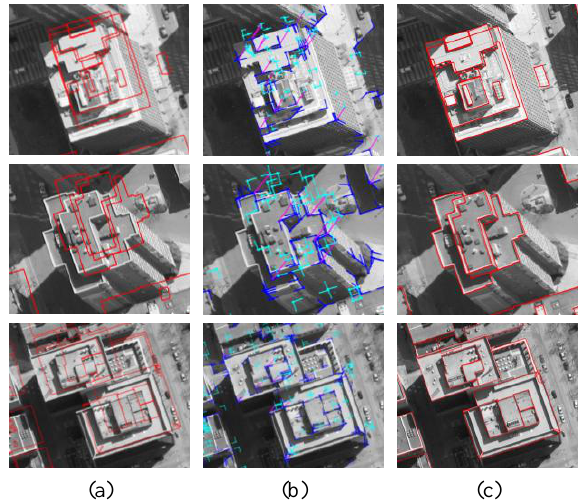
Figure 7. Results with manually digitized building models: (a) with error-contained EOPs, (b) matching relations (magenta) between edged corner features extracted from the image (blue) and the models (cyan) and (c) with refined EOPs